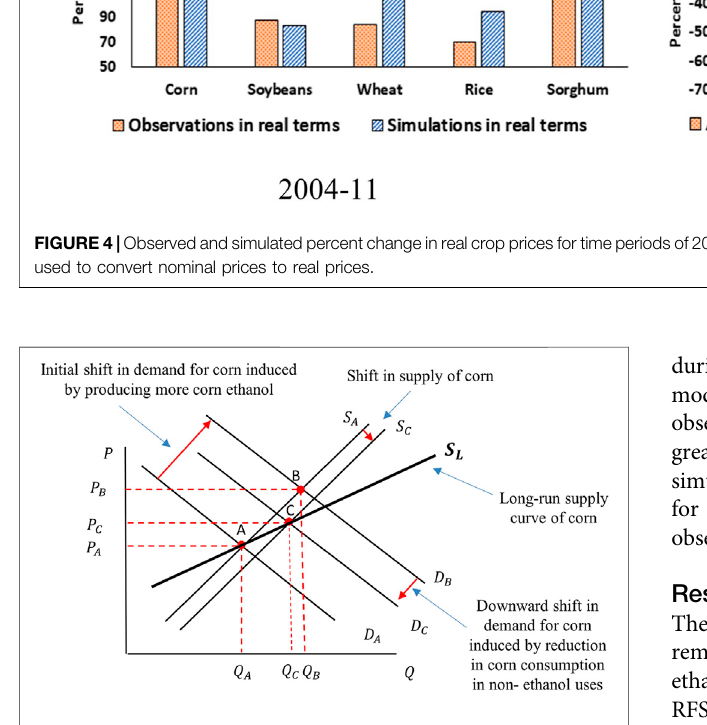
Frontiers in Energy Research |